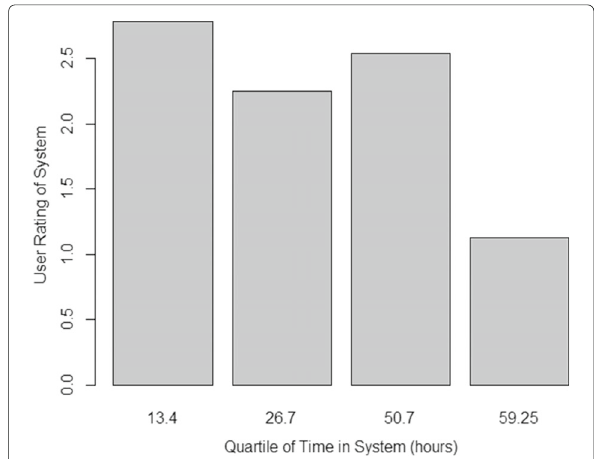
Fig. 6 User attitude toward system by quartile of time spent in